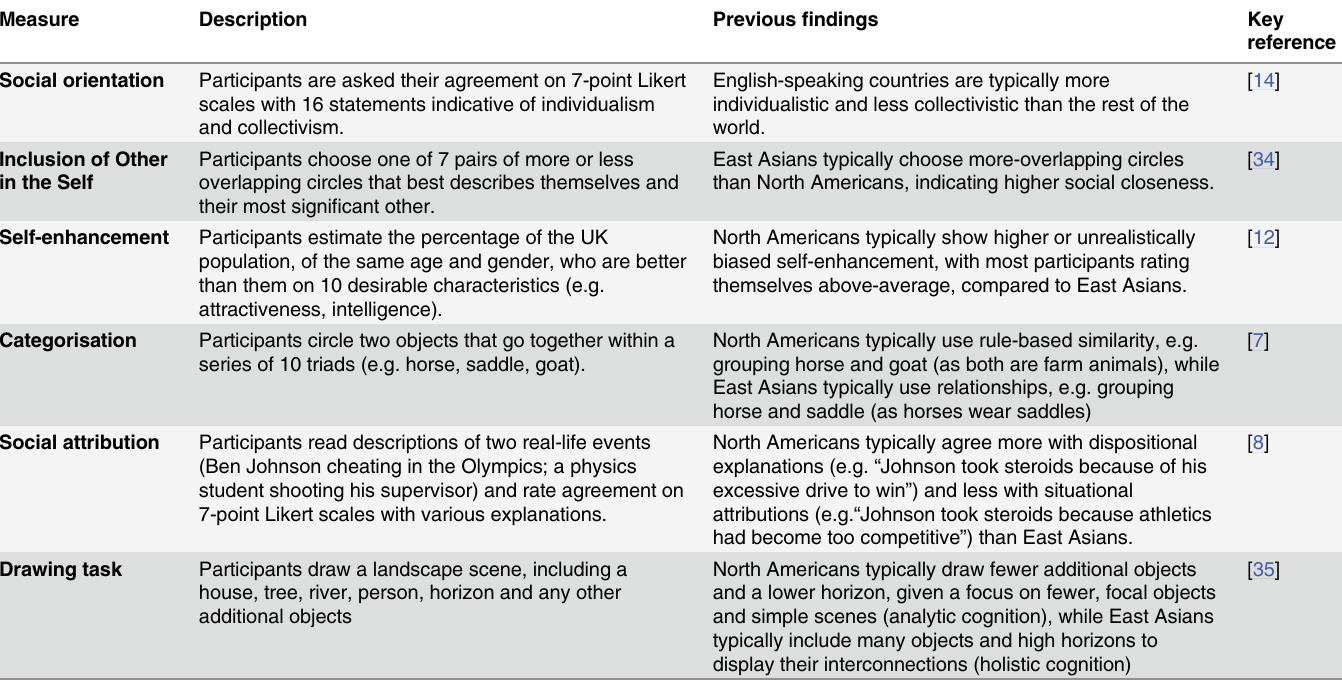
Table 2. Tasks used in the present study, and previously-found cultural differences. Measure Description Previous fi ndings Social orientation